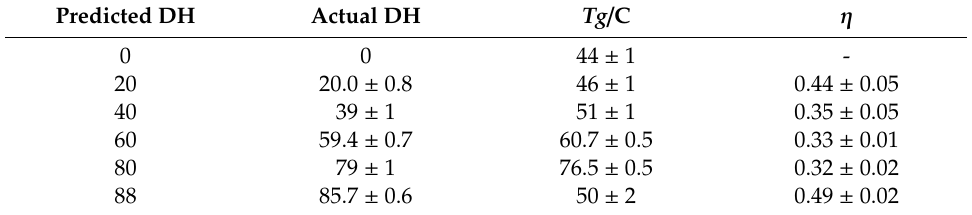
Figure 2. ( a ) Tg shifts of polymers for mixtures of sorbitol (S), octanoic acid (OA), or sodium dodecyl sulfate (SDS) with PVAc ( X = 0, 20, 90). Horizontal white lines represent the Tg of pure polymer from which the Tg is shifted to lower (compatibility/plasticisation) or higher values (anti-plasticisation). A qualitative interpretation of the compatibility is presented in the table on the right based on the DSC results and Hansen solubility parameters (HSP) predictions. A letter P is attributed when color attributions are based only on HSP predictions. ( b ) Phase diagram of dried mixtures of sorbitol and PVAc ( X = 0, 20, 90) obtained from cloud point analysis at room temperature, where Φ 1 represents the one-phase region and Φ 2 the clouded region. The technique is described elsewhere [21]. ( c ) Thermogravimetric analysis (TGA) of pure PVAc 0DH (orange dashed line) and with this addition of 5%, 10%, 15%, and 20% of sorbitol (shades of grey lines) and pure sorbitol (red dashed line). Table 2. Degree of hydrolysis (DH) for each grade of PVAc and its corresponding glass transition measured by di ff erential scanning calorimetry (DSC) and blockiness obtained by 13 C